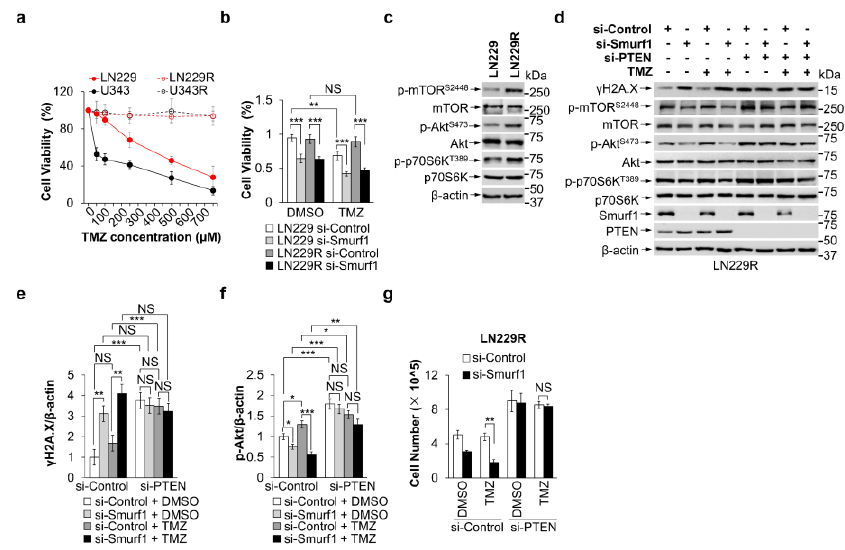
Figure 3. Smurf1 suppression restores the sensitivity of TMZ − resistant GB cells. ( a ) Cell viability was measured after 48 h treatment with increasing concentrations of TMZ in LN229, U343, LN229R, and U343R using MTT assay. ( b ) LN229 and LN229R were transfected with si − Control or si − Smurf1 followed by DMSO or TMZ (250 μM, 48 h) treatment. MTT assay was performed to evaluate the cytotoxicity of treatments on each group. Values were normalized against the amount of LN229 and LN229R treated with control siRNA oligos and DMSO. ( c ) LN229 and LN229R were prepared for whole − cell lysates and examined by immunoblotting with anti − p − mTOR S2448 , anti − mTOR, anti − p − Akt S473 , anti − Akt, anti − p − p70S6K T389 , and anti − p70S6K antibodies. Blots were probed with anti −β− actin antibody to check protein loading. ( d – g ) LN229R cells were transfected with